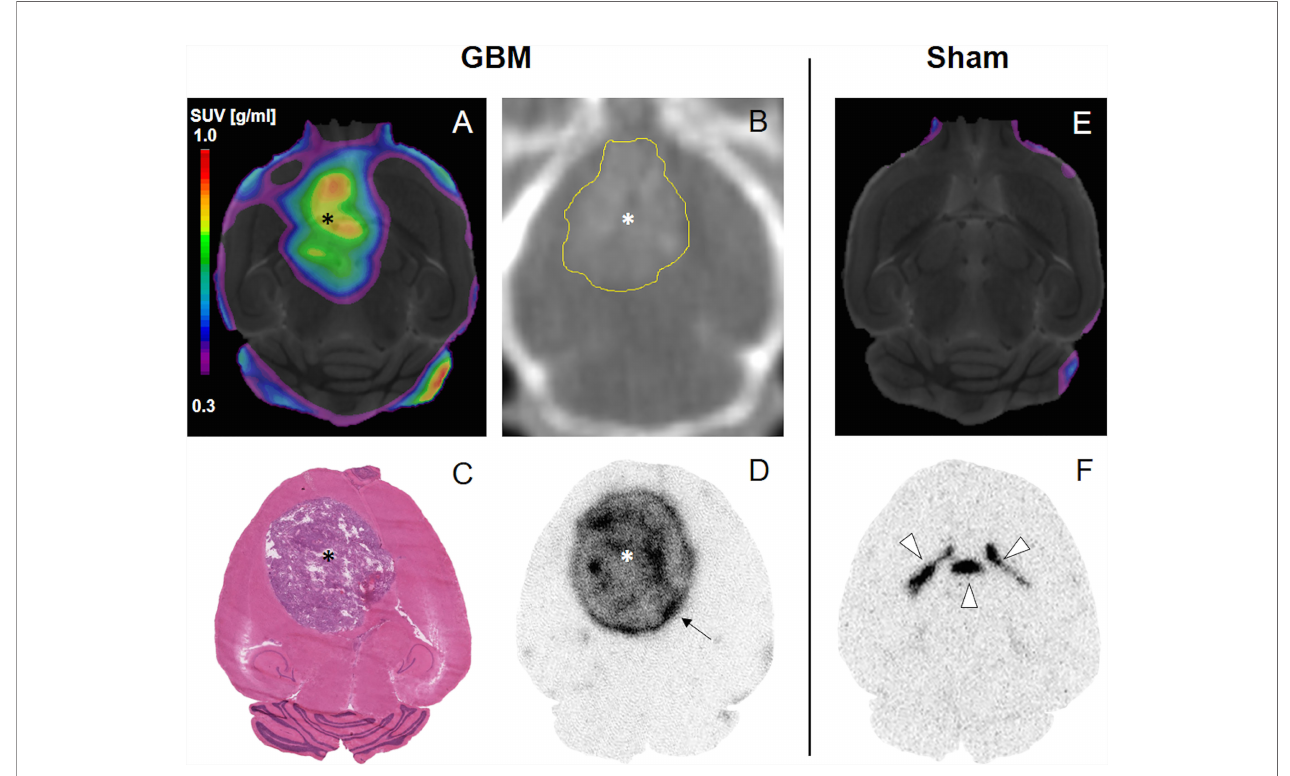
FIGURE 2 | 18 F-PSMA-1007 PET (A, E) , CT (B) , H&E (C) and ex vivo ARG (D, F) . PET images were fused onto an MRI template. Asterisk, tumor. Yellow delineation in (B) for better visibility. Arrow, Increased peripheral signal. Arrowheads, ventricles; circumventricular